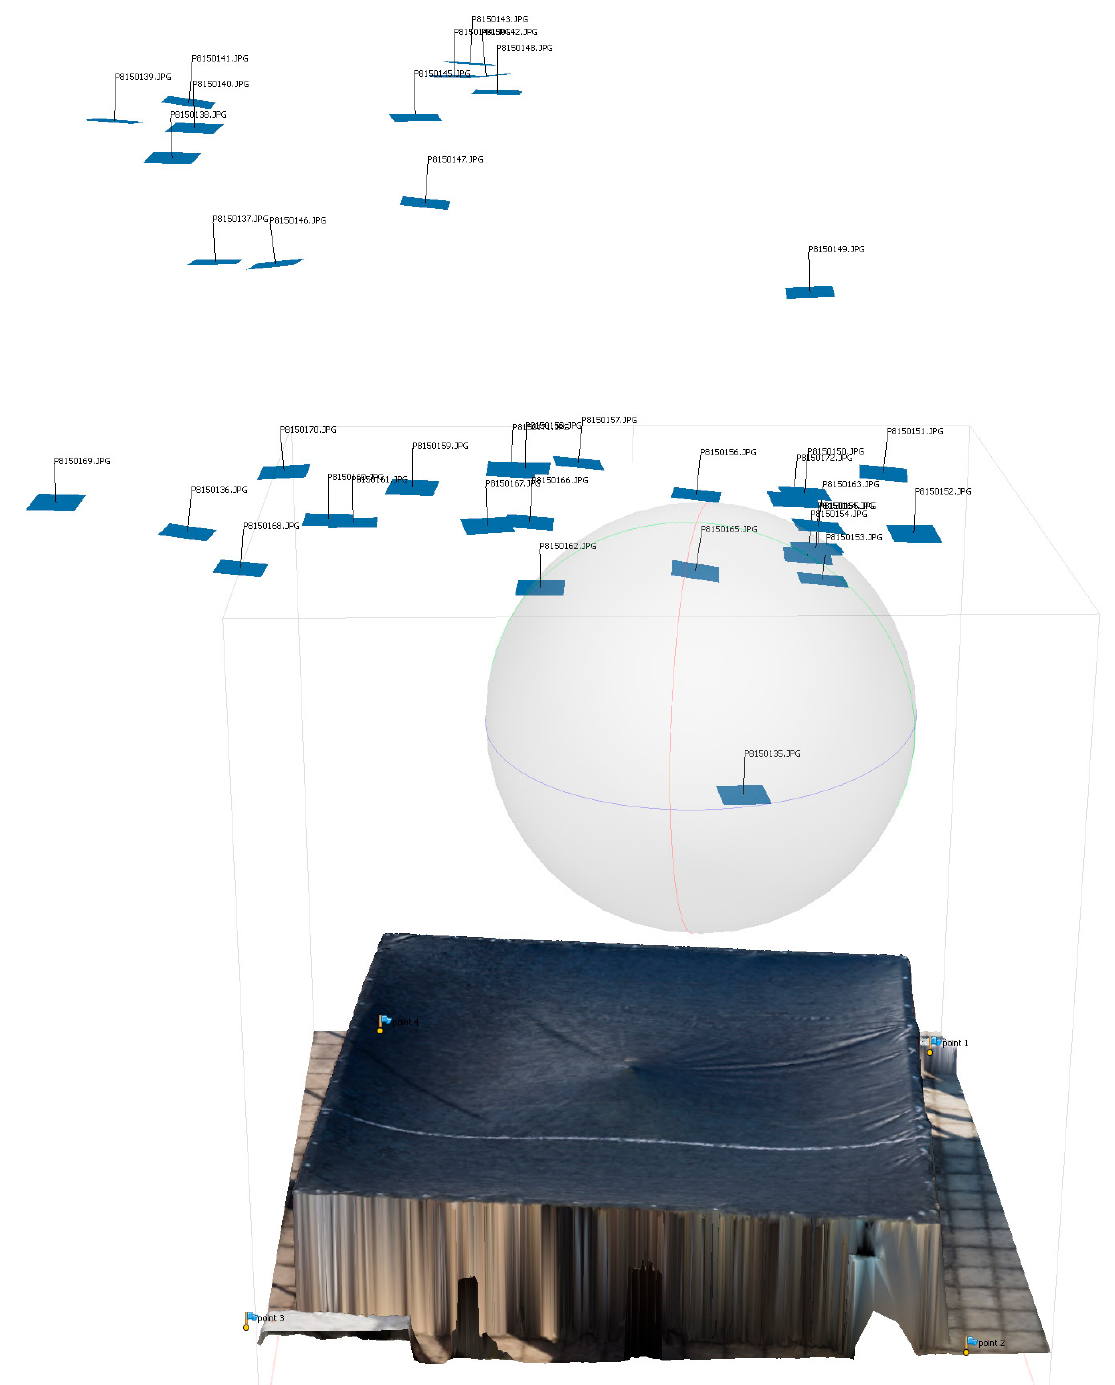
Figure 25. Location of photographs taken by UAV relative to rooftop structure. Table 4. Flight parameters.